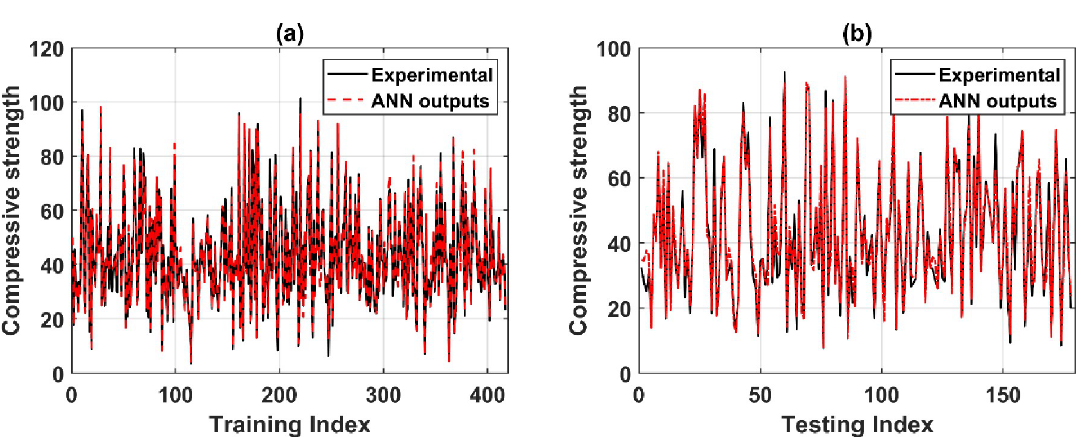
Fig 8. Experimental and predicted shear strength results in function of sample index for the training and testing datasets.